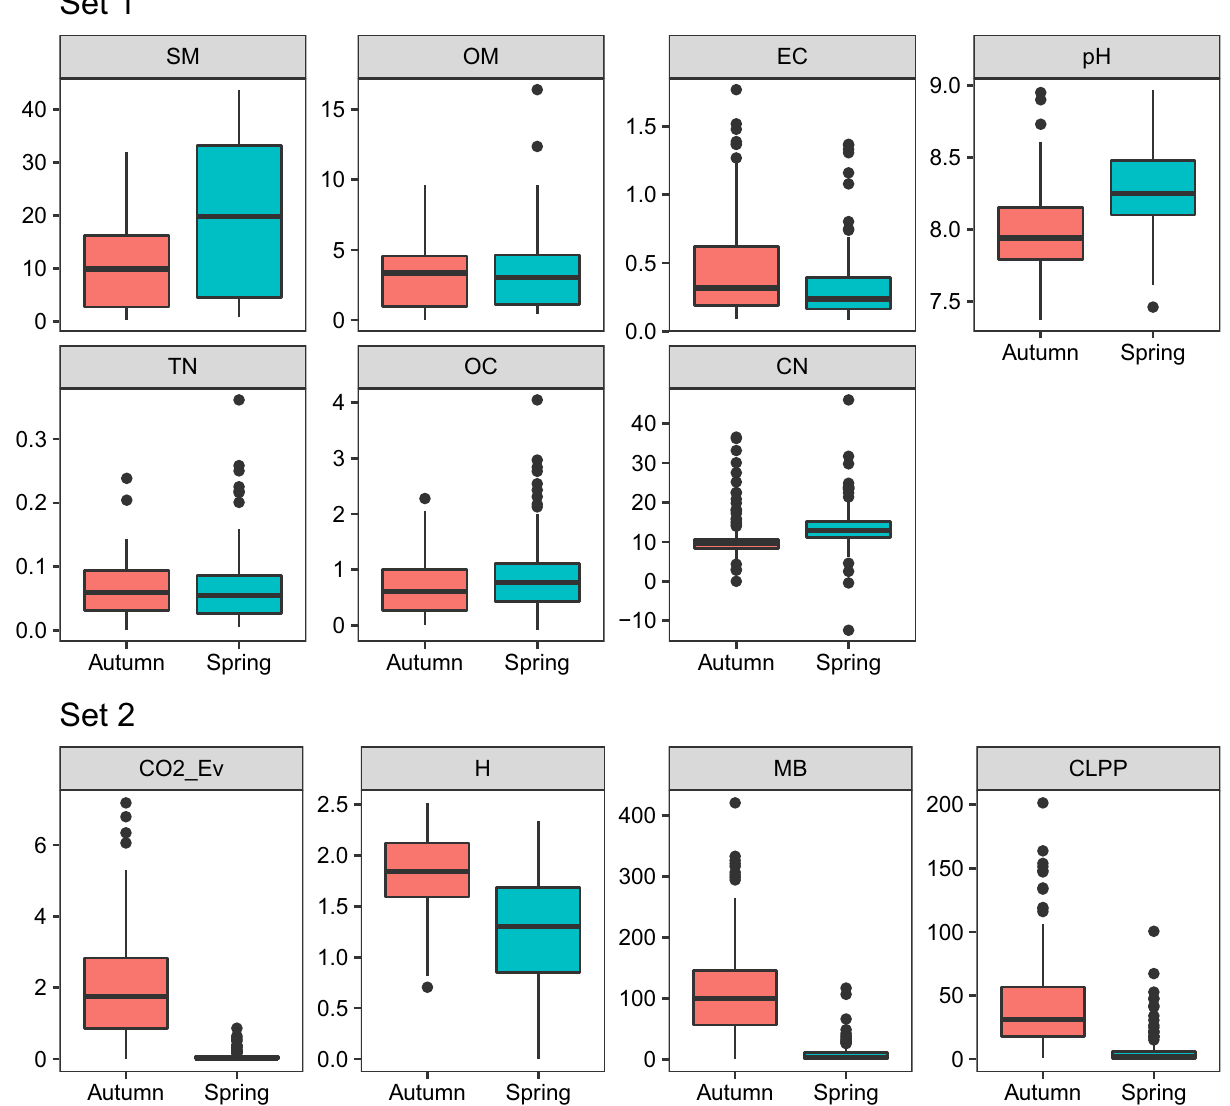
Figure 2. Distribution of soil sample properties for samples collected in autumn and spring. The properties are marked according to their role in the subsequent analyses as Set 1 variables and Set 2 variables. The solid line in each box indicates the data median, the boxes indicate the 1st and 3rd quartiles, whiskers extend to at most 1.5 times the size of a box, while observations above the upper whiskers and below the lower whisker are